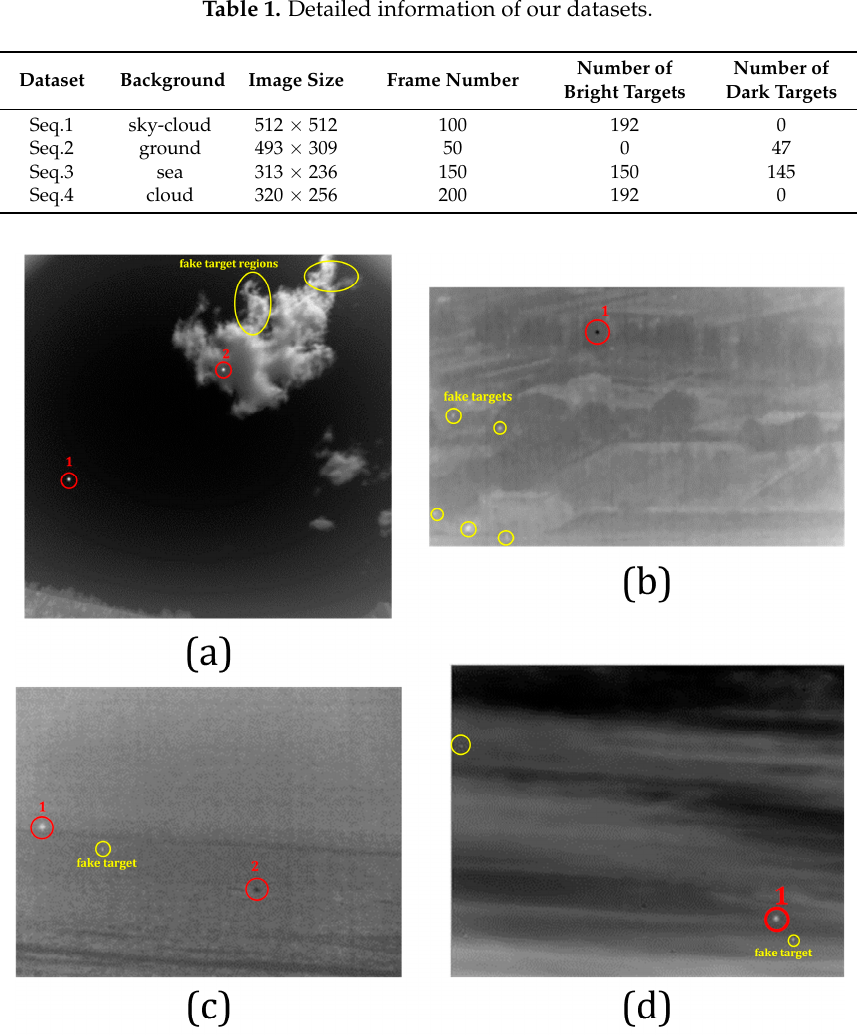
Figure 4. First frames of the tested infrared (IR) sequences: ( a ) Seq.1; ( b ) Seq.2; ( c ) Seq.3; ( d ) Seq.4.